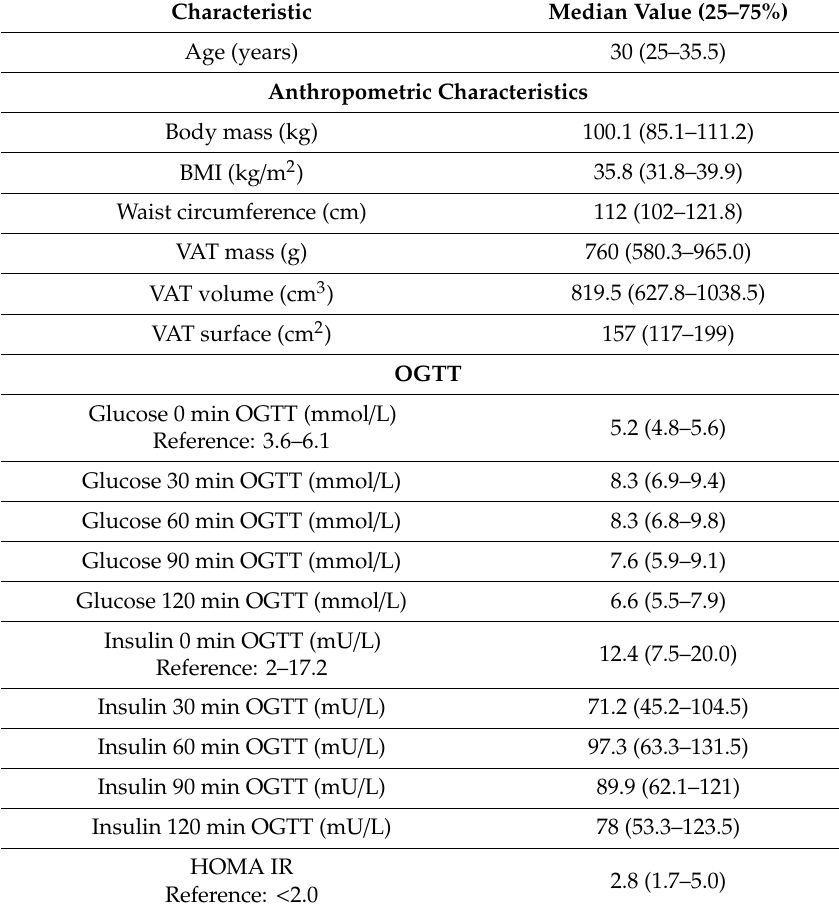
Table 1. Characteristics of polycystic ovary syndrome (PCOS)